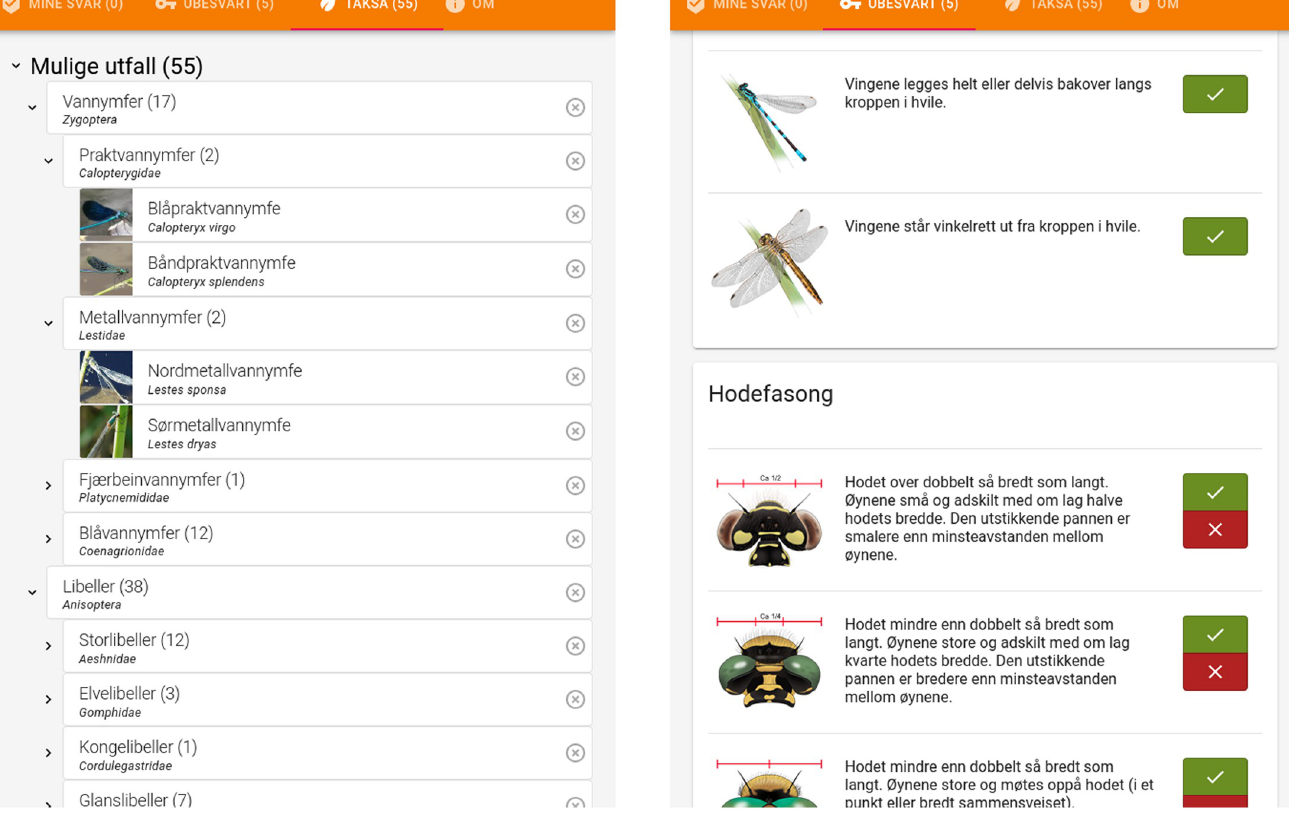
Fig 5. An example implementation of a Clavis key graphical user interface. Based on a working Odonata key previously published by the Norwegian Biodiversity Information Centre. A hierarchical list of taxa (left) is reduced by providing input on characters (right). Only characters relevant for all remaining taxa are shown. Drawings CC BY 4.0 Hallvard